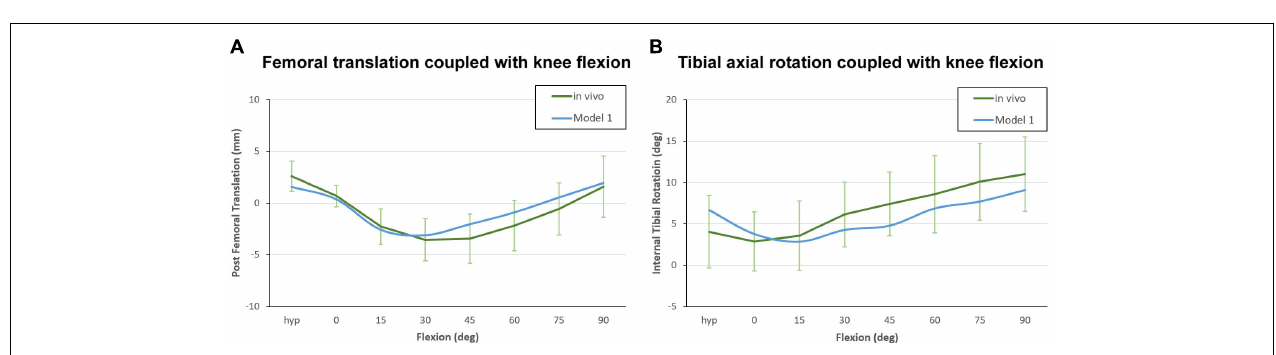
FIGURE 5 | Kinematic curve of Model 1 plotted against in vivo data for model validation. (A) Femoral translation coupled with knee flexion, with positive values indicating posterior translation relative to the reference position. (B) Tibial axial rotation coupled with knee flexion, with positive values indicating internal tibial rotation relative to the